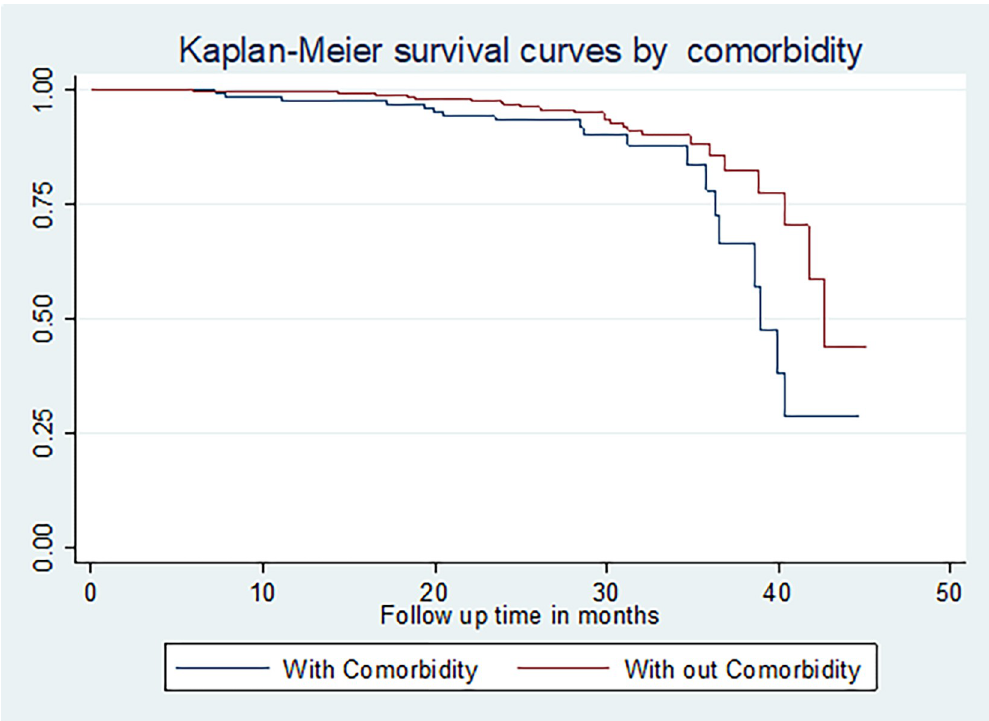
Fig 5. The Kaplan-Meier survival curves comparing survival time of cervical cancer patients by co-morbidity (n = 422, March 2021).